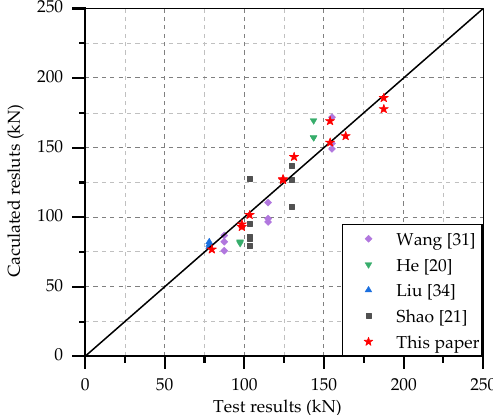
Figure 9. Comparison of test and calculated results of shear capacity in other literatures.